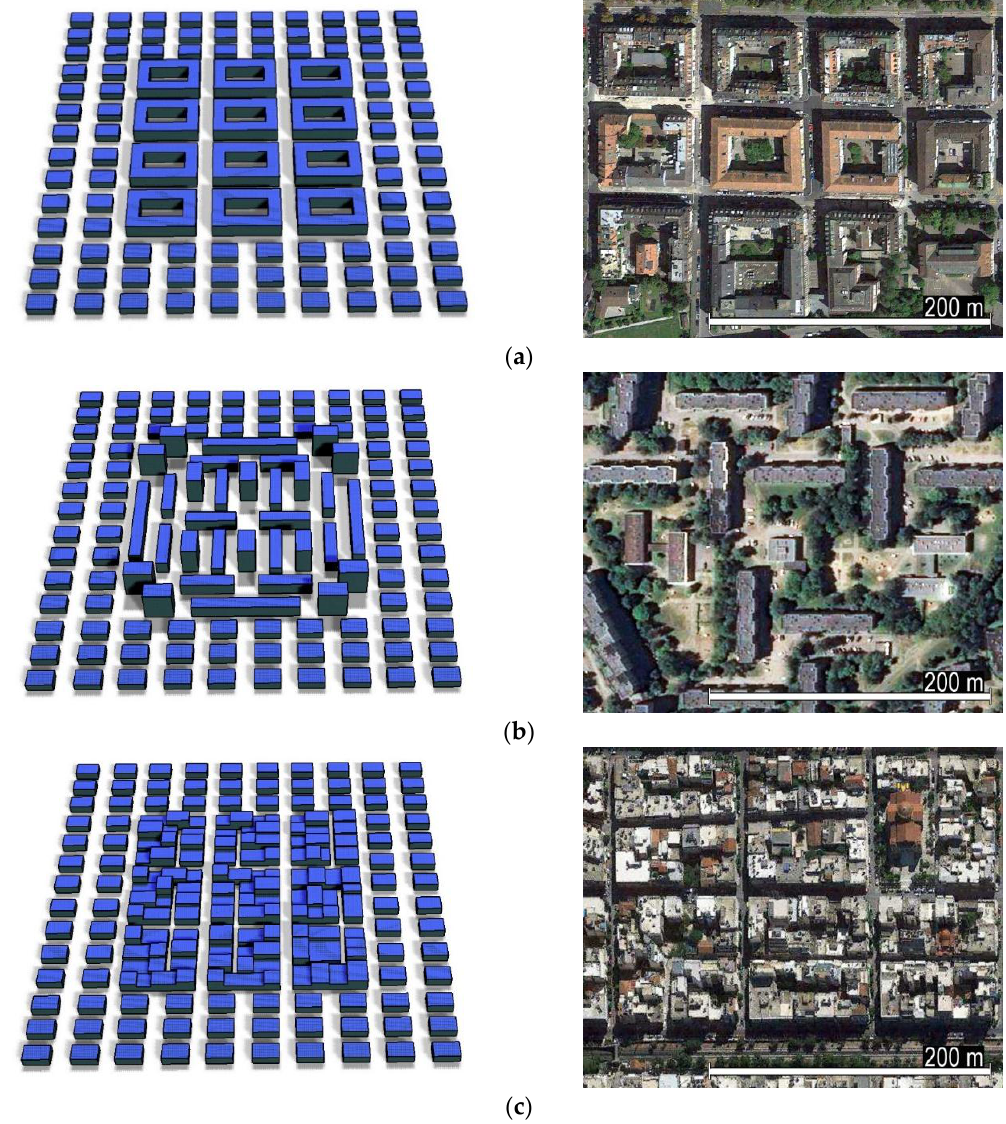
Figure 1. Urban morphologies with uniform surrounding buildings used for CFD analysis in comparison to the real city images: ( a ) UM-1—Zürich, Switzerland; ( b ) UM-2—Kaunas, Lithuania; ( c ) UM-3—Athens, Greece. Map data © 2015 Google.